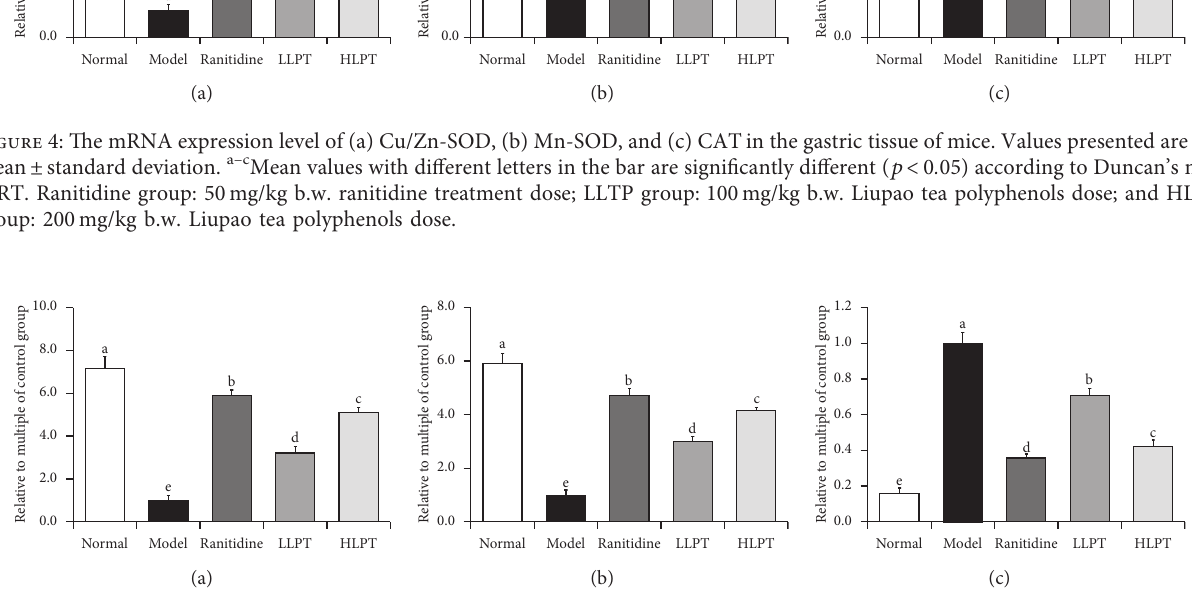
Figure 5: The mRNA expression level of (a) nNOS, (b) eNOS, and (c) iNOS in the gastric tissue of mice. Values presented are the mean ± standard deviation. a-c Mean values with different letters in the bar are significantly different ( p < 0 . 05) according to Duncan’s new MRT. Ranitidine group: 50mg/kg b.w. ranitidine treatment dose; LLTP group: 100mg/kg b.w. Liupao tea polyphenols dose; and HLTP group: 200mg/kg b.w. Liupao tea polyphenols dose.